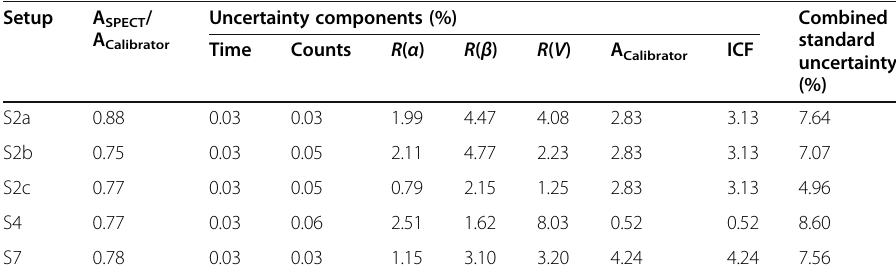
Table 6 Uncertainty budget for renal cortex activity ratios (A SPECT : SPECT-based activity, A Calibrator : radionuclide calibrator-based activity, R( α ) / R( β ) / R(V): uncertainty components introduced by the recovery originating from α , β and V, respectively) Setup